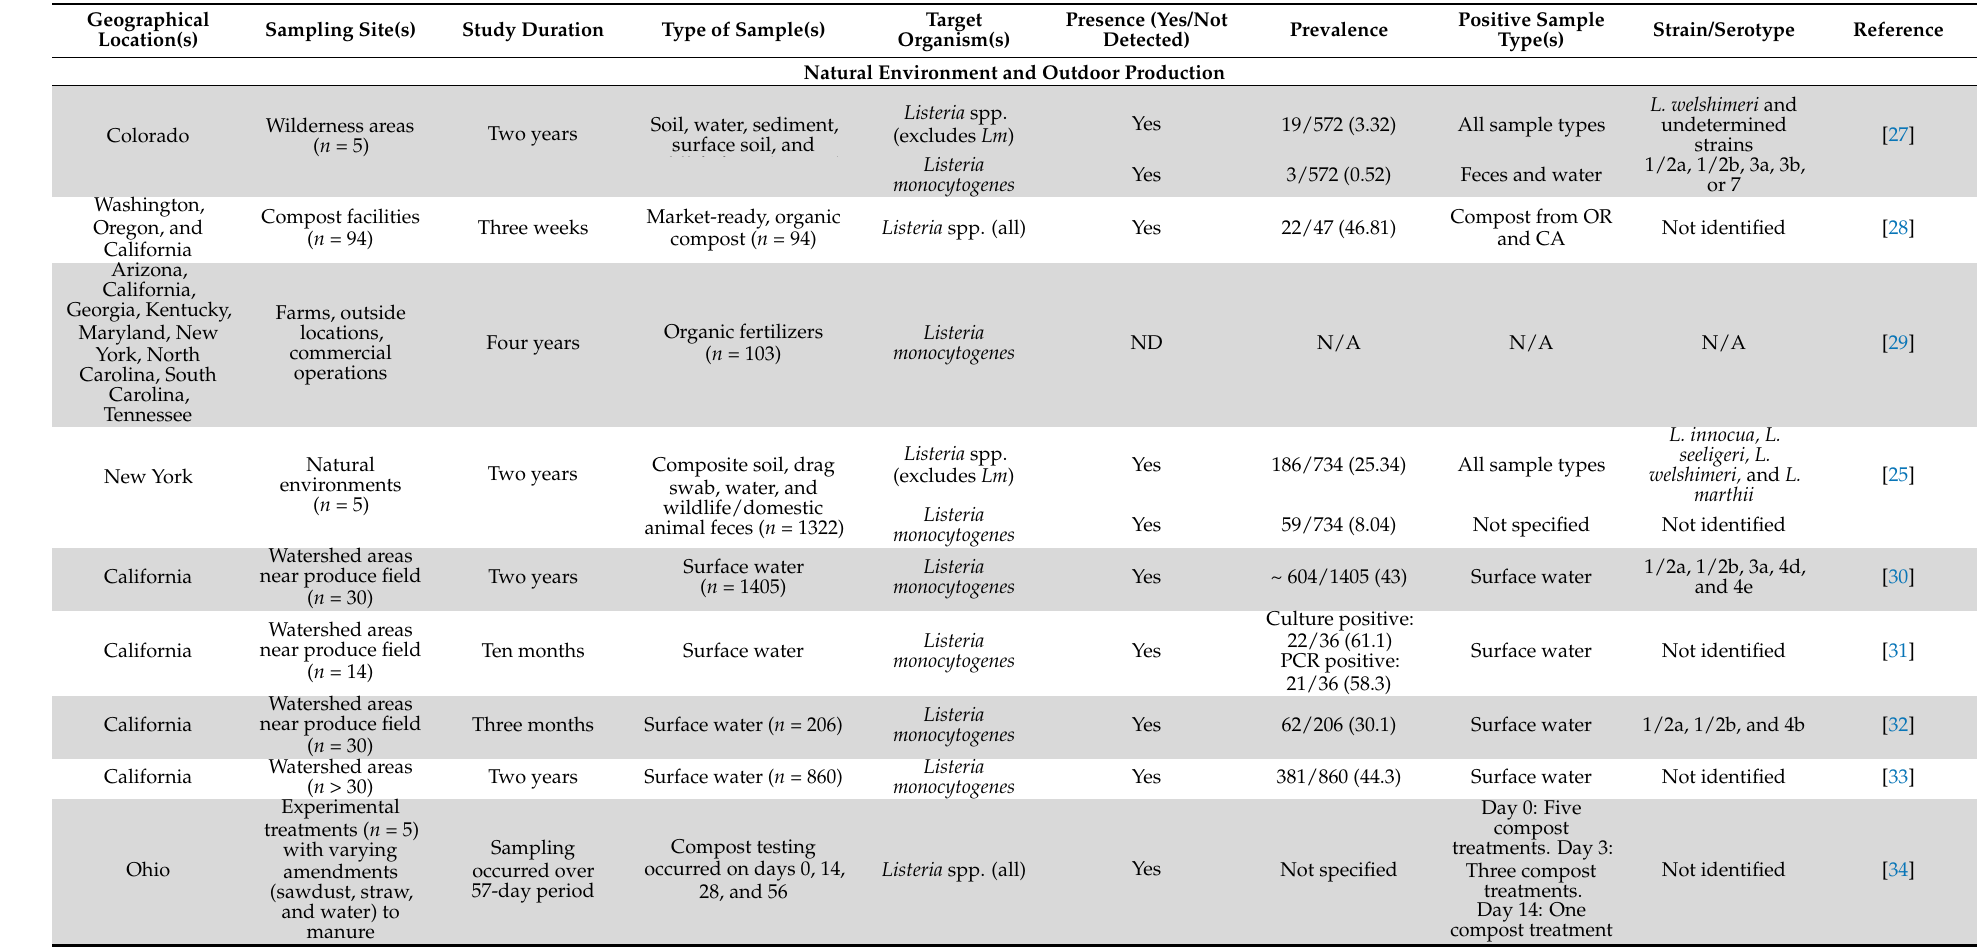
Table 2. Summary of Listeria spp. and L. monocytogenes prevalence throughout the fresh produce supply chain. All Listeria species (including L. monocytogenes ) are considered when Listeria spp. are the only target organisms within a study. However, Listeria spp. exclude L. monocytogenes when both are included in target organisms within a study. Prevalence is given in number of positive samples divided by the total number of samples with corresponding percentage in